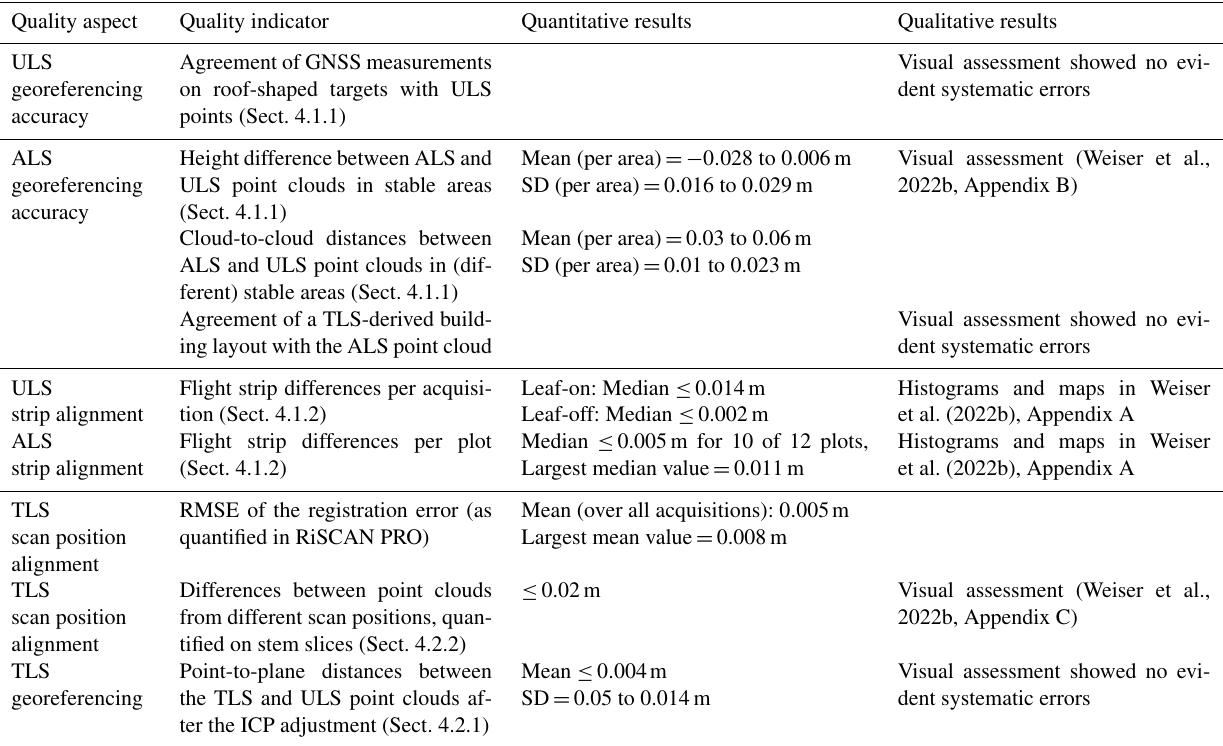
Table 6. Summary of the different indicators for georeferencing and alignment quality. SD is the standard deviation. Quality